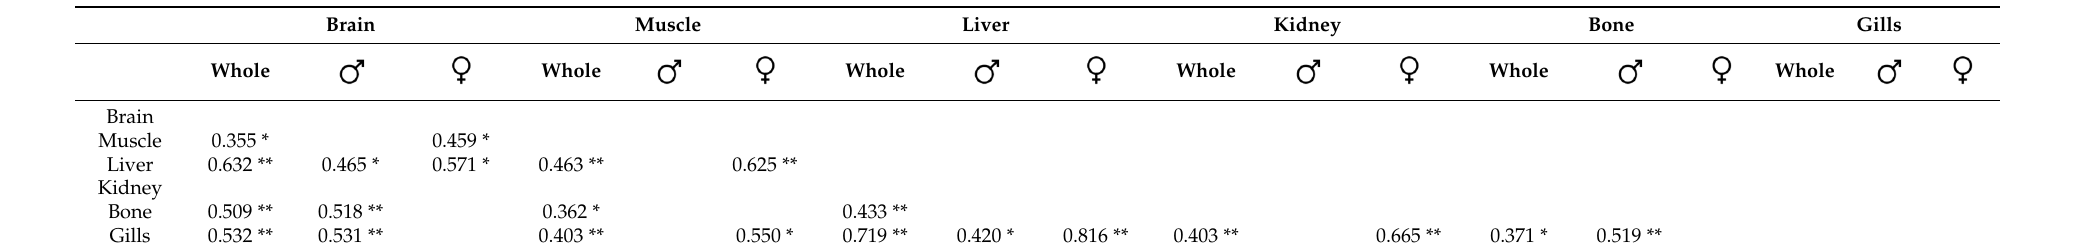
Table 4. Statistically significant correlations for Se concentration between tissues of ABFT.